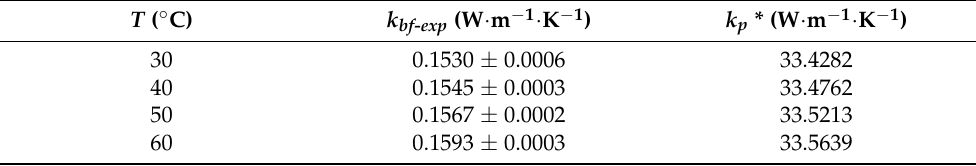
Table 6. Thermal conductivity at different temperatures of the base fluid and particles.